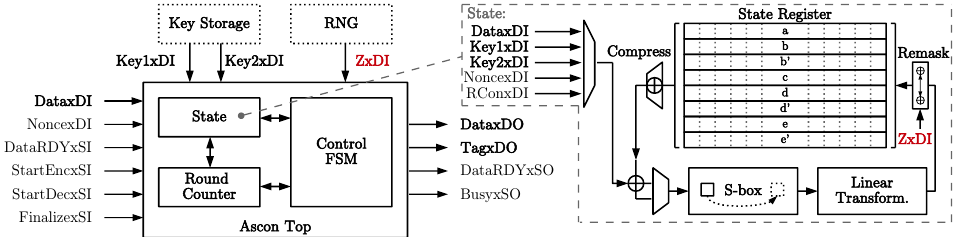
Figure 8: Hardware design overview of